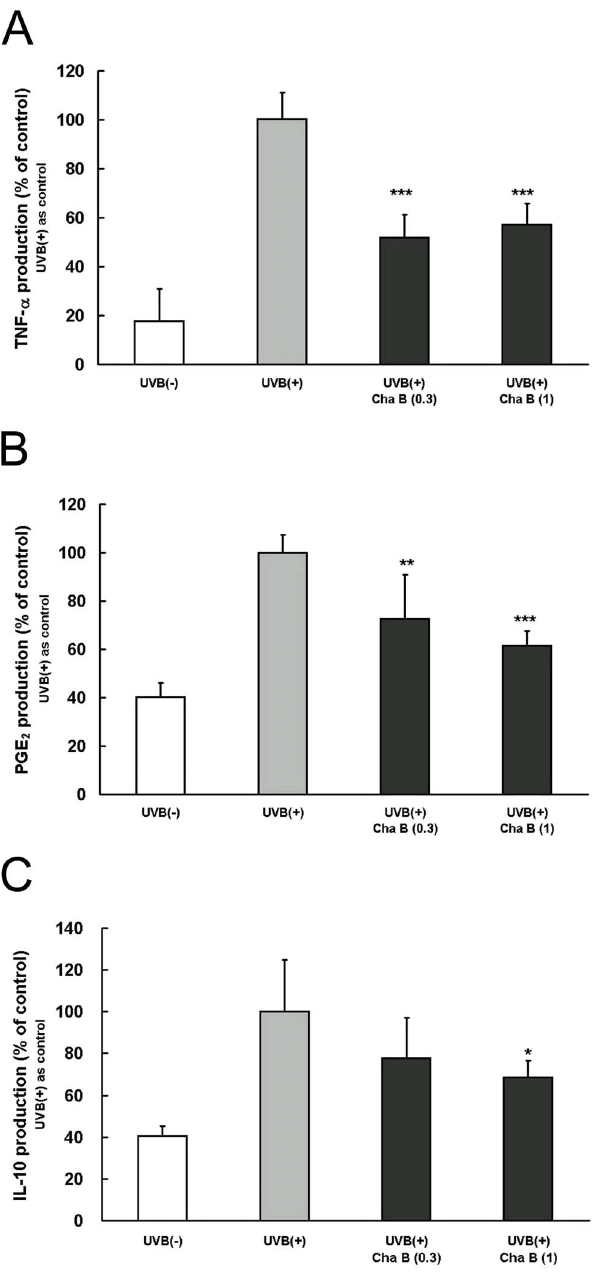
Figure 2. Chafuroside B decreased the UVB-induced produc- tion of TNF- a , PGE 2 , and IL-10 in human keratinocytes. NHEK were irradiated with UVB (20 mJ/cm 2 ), and then treated with chafuro- side B (0.3 and 1 m M). After 48 h, supernatants were collected and the levels of TNF- a , PGE 2 , and IL-10 were evaluated by ELISA. (A) TNF- a . (B) PGE 2 . (C) IL-10. Cha B = Chafuroside B. All data are expressed as the mean 6 SD ( n =4). * P , 0.05, ** P , 0.01 and *** P , 0.001 compared with UVB ( + ).